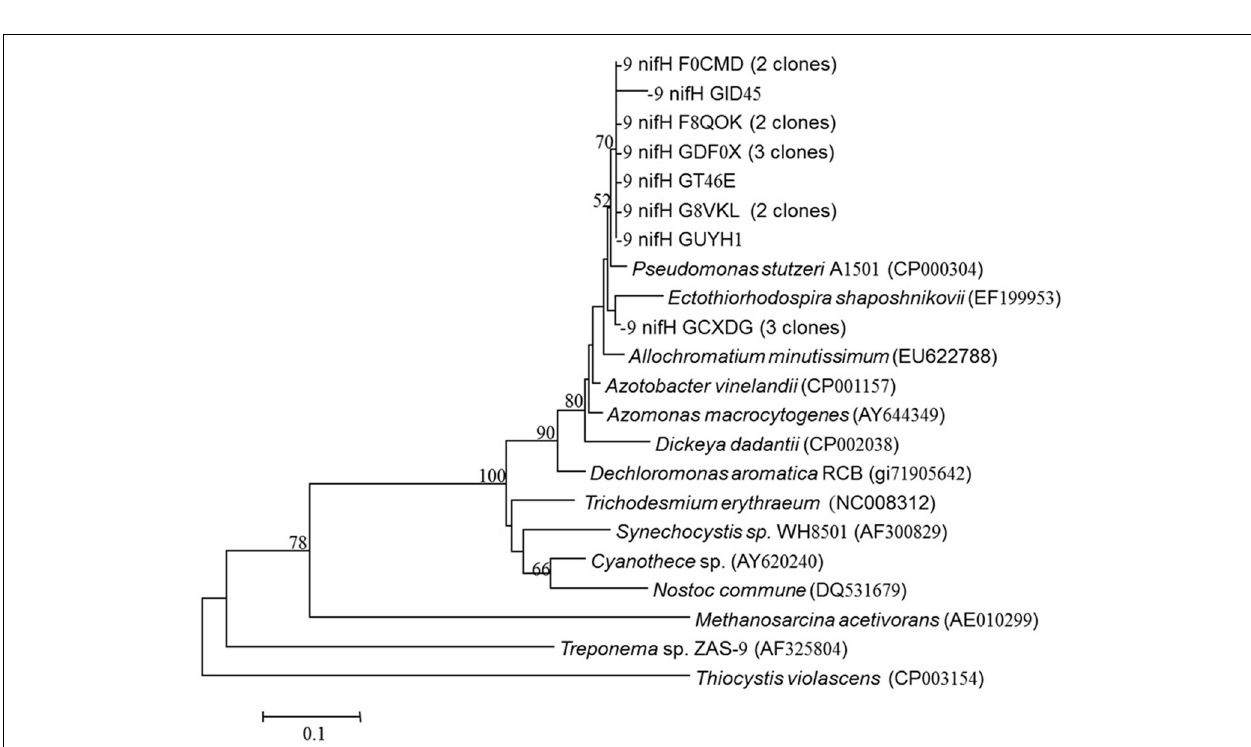
depth to which we added 4 concentrations of pure gum xanthan. Values are averages and error bars are standard deviations of three independent replicates performed for each control and treatment incubation.